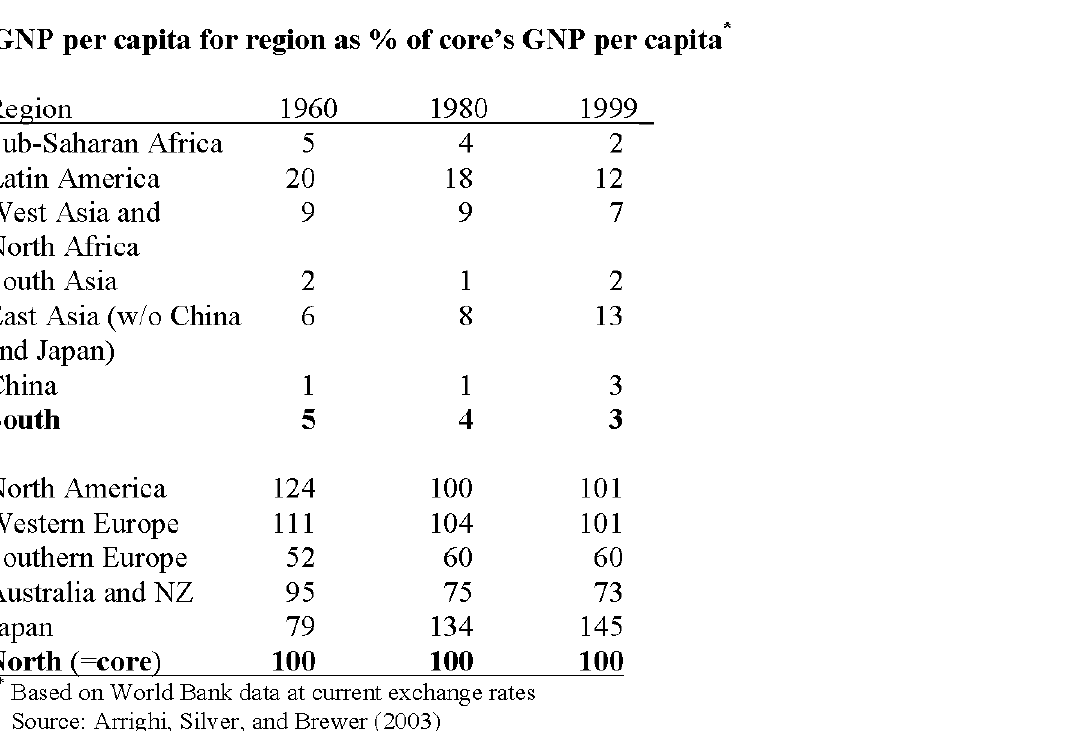
Table 2. GNP per capita for region as% of core's GNP per